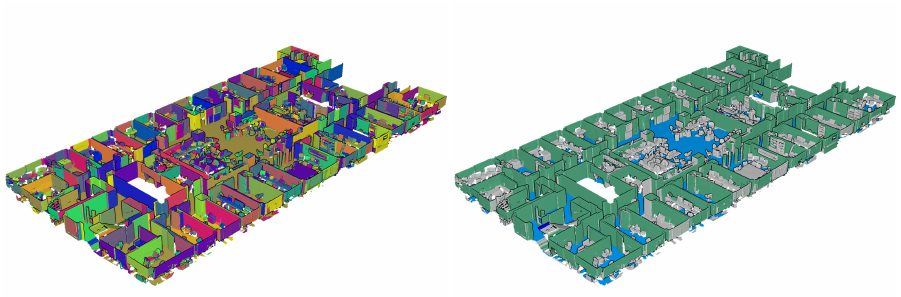
Figure 3. From left to right: a segmented point cloud following [14]; The Classification results on segment-based